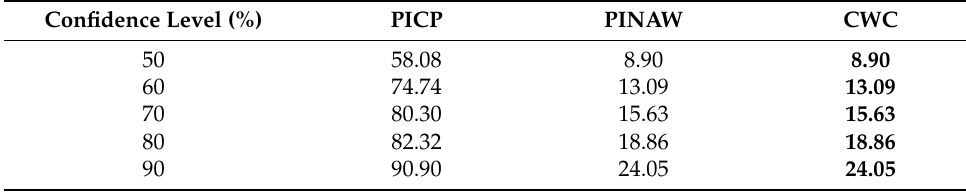
Table 5. Three-hour-ahead PIs using WRFD and WEPS (Method 1b).